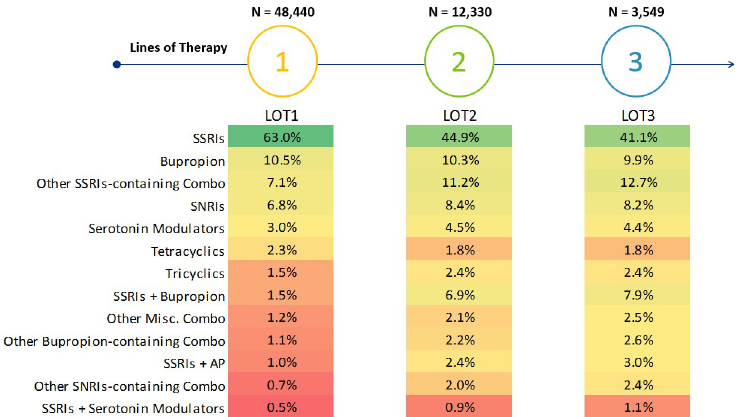
Fig 4. Patterns of antidepressant/antipsychotic treatment during the 1st treated MDD episode. AP: antipsychotic; Combo: combination; LOT: line of therapy; MDD: major depressive disorder Misc: miscellaneous; SNRIs: serotonin norepinephrine reuptake inhibitors; SSRIs: selective serotonin reuptake inhibitors.